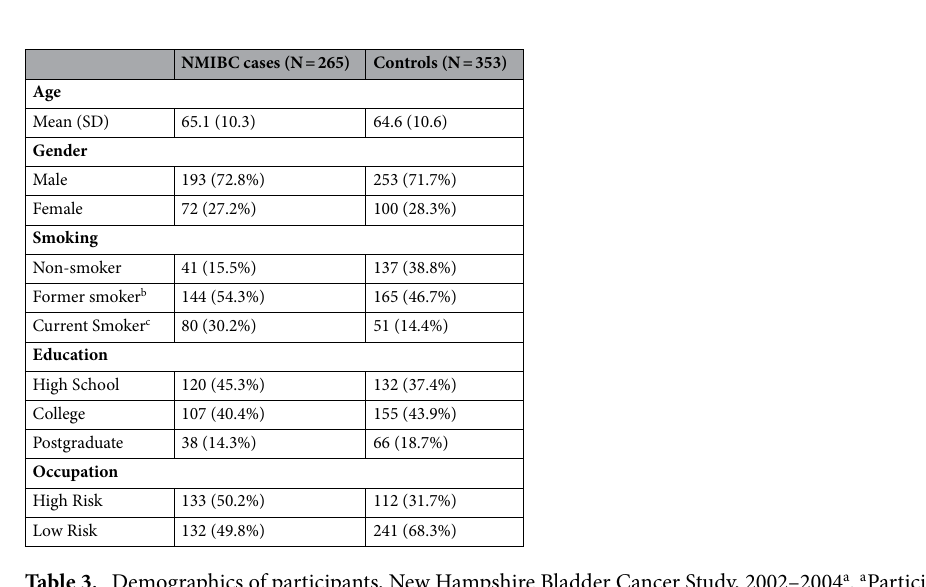
Table 3. Demographics of participants, New Hampshire Bladder Cancer Study, 2002–2004 a . a Participants were 265 non-muscle invasive bladder cancer (NMIBC) cases and 353 controls of the New Hampshire Bladder Cancer Study. b “Former smokers” quit smoking more than 1 year before they were diagnosed as cases or selected as controls. c “Current smokers” still smoked or quit smoking less than 1 year before they were diagnosed as cases or selected as